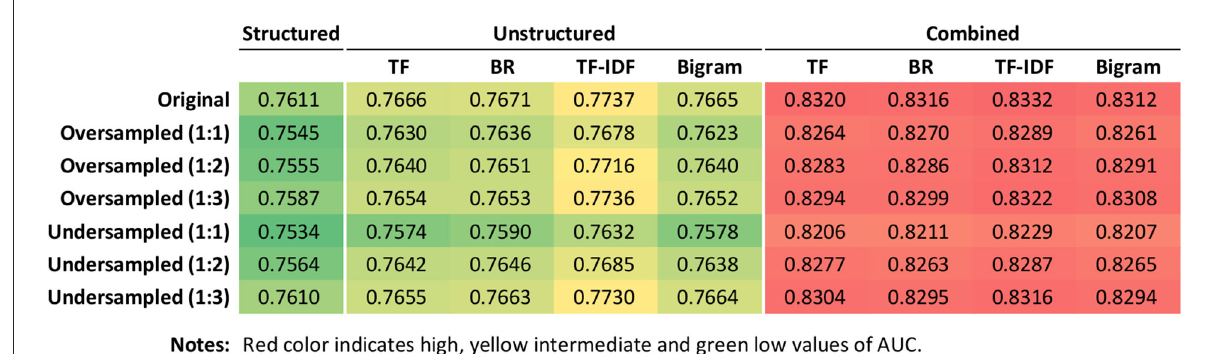
FIGURE3 Heat map showing AUC values across machine learning models with different combinations of text vectorization techniques and resampling methods. AUC, area under the receiver operating characteristic curve; BR, binary representation; TF, term frequency; TF-IDF, term frequency with inverse document frequency.